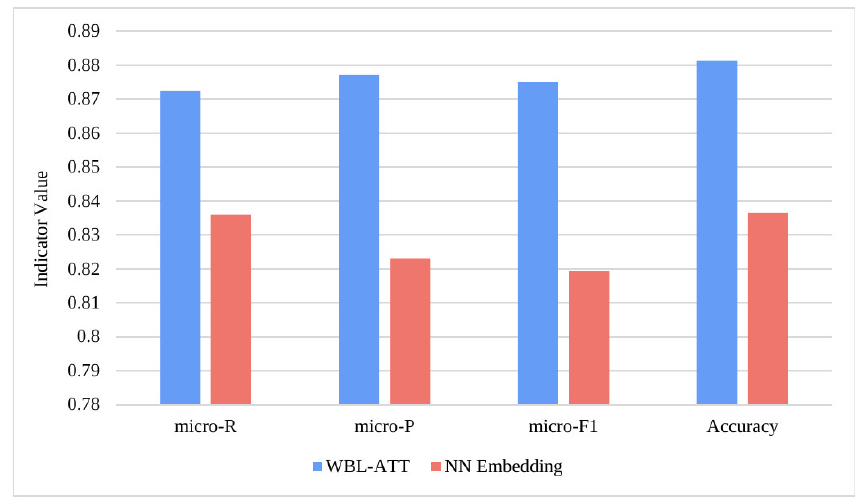
Figure 7. Word embedding model Figure 7 . Word embedding model comparison.